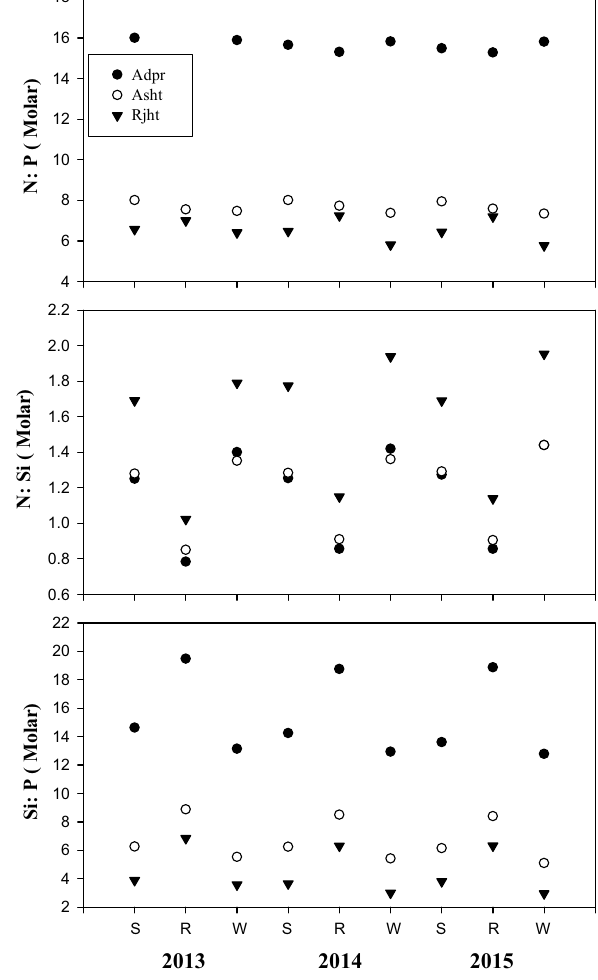
Fig. 5 Spatiotemporal variations in N/P/Si stoichiometry at study sites in the Ganga River; S summer, R rainy season, W